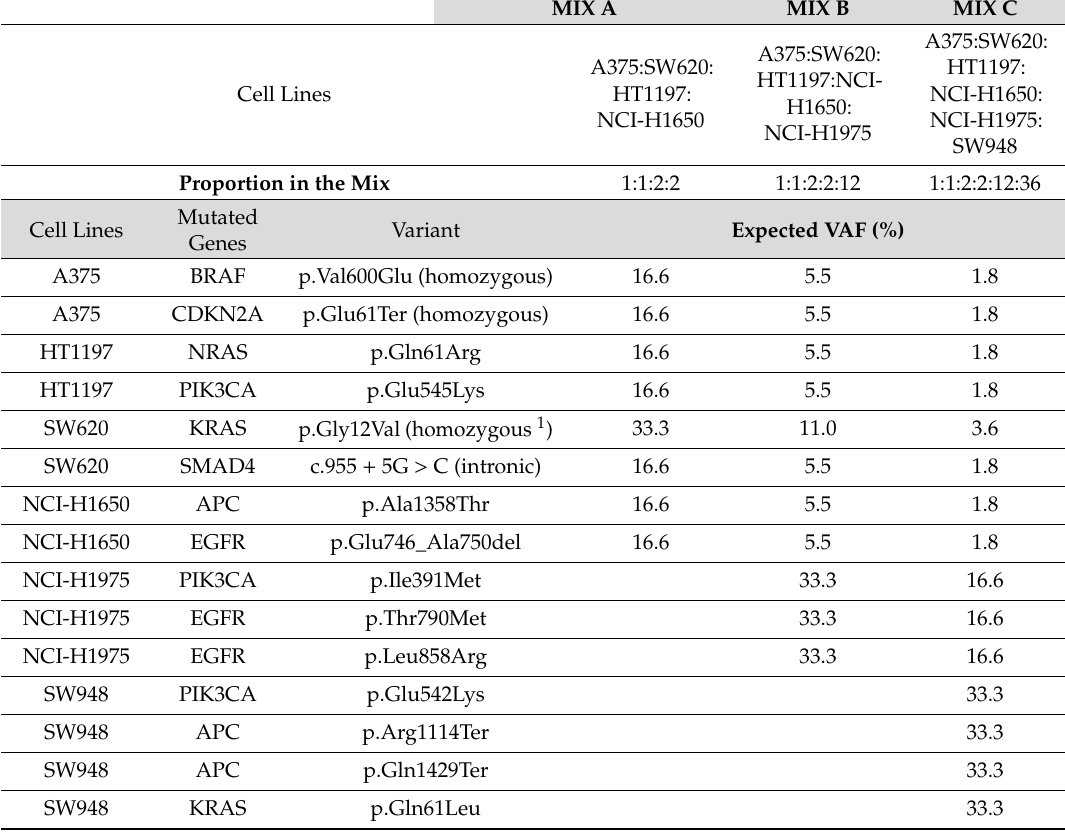
Table 1. Control DNA samples obtained from cell line mixes in di ff erent proportions.